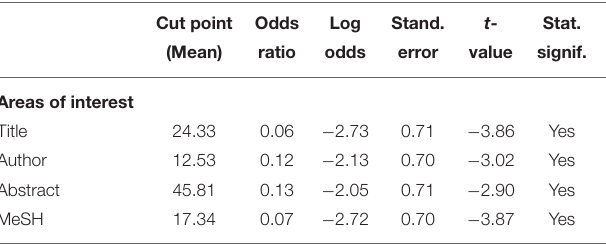
styles was also collected by a computerized test (Peterson et al., TABLE 1 | Summary of the relationship between search task difficulty and eye gaze (N search task difficulty = 256, N eye gaze = 256; statistical significance at